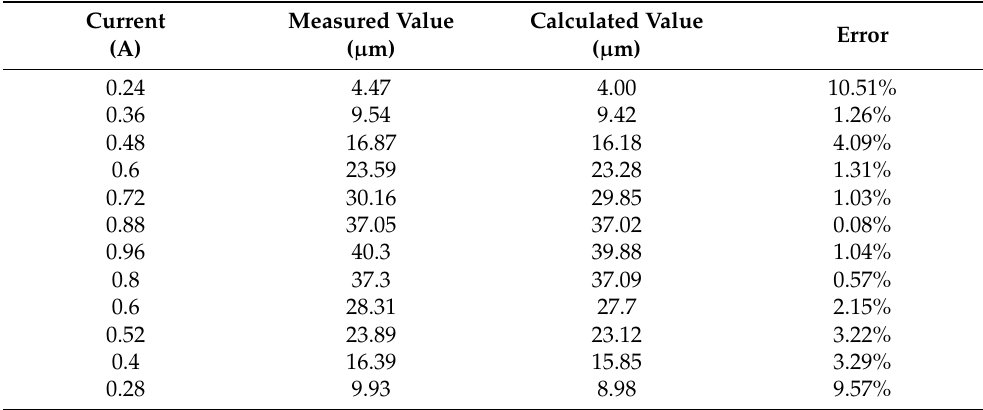
Figure 8. Comparison results under different current values. Table 4. Experimental verification